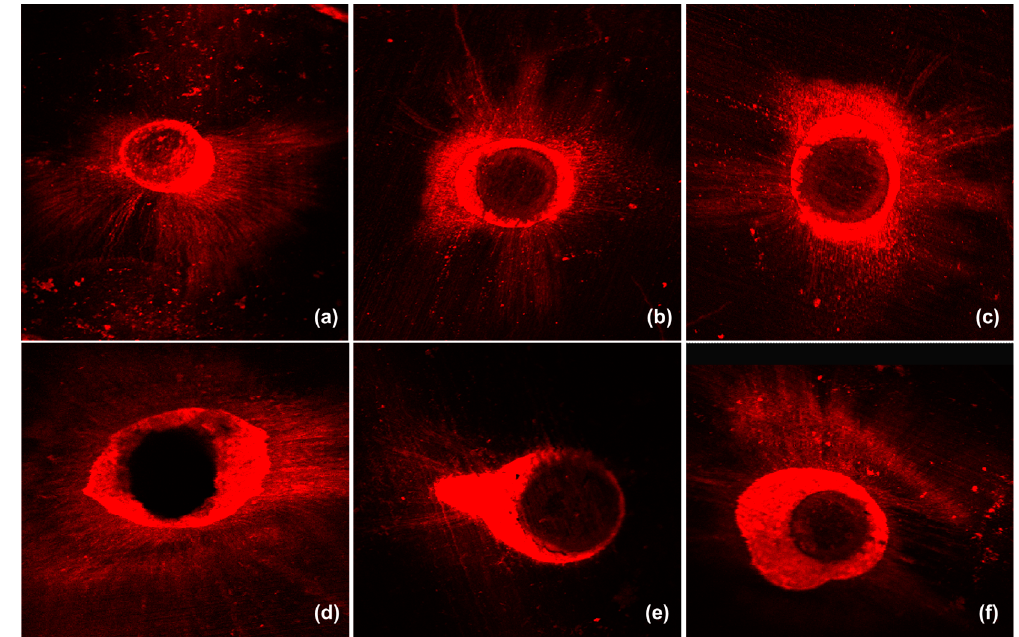
Figure 4. Representative images of sealer penetration under confocal scanning laser microscopy in Bio-G ( a ), BioRoot RCS ( b ), and iRoot SP ( c ) at the 5 mm level and Bio-G ( d ), BioRoot RCS ( e ), and iRoot SP ( f ) at the 10 mm level.